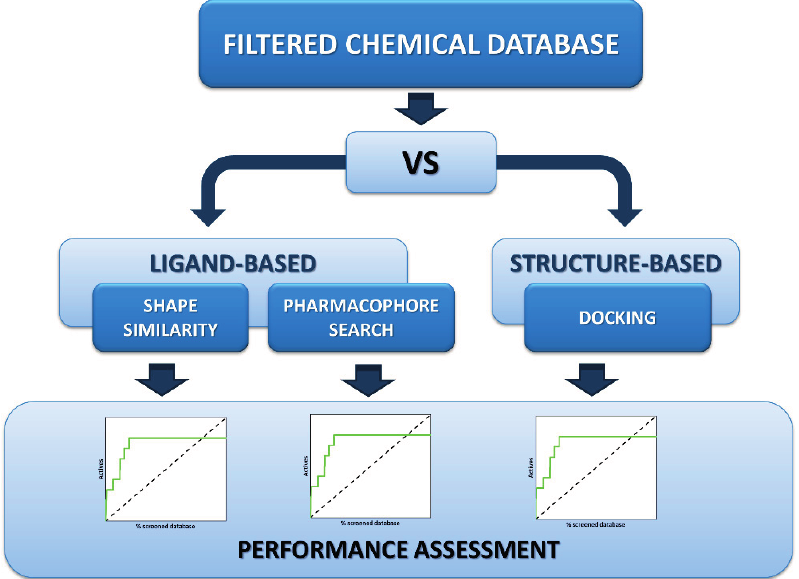
Figure 4. Virtual screening workflow applied in the present computational